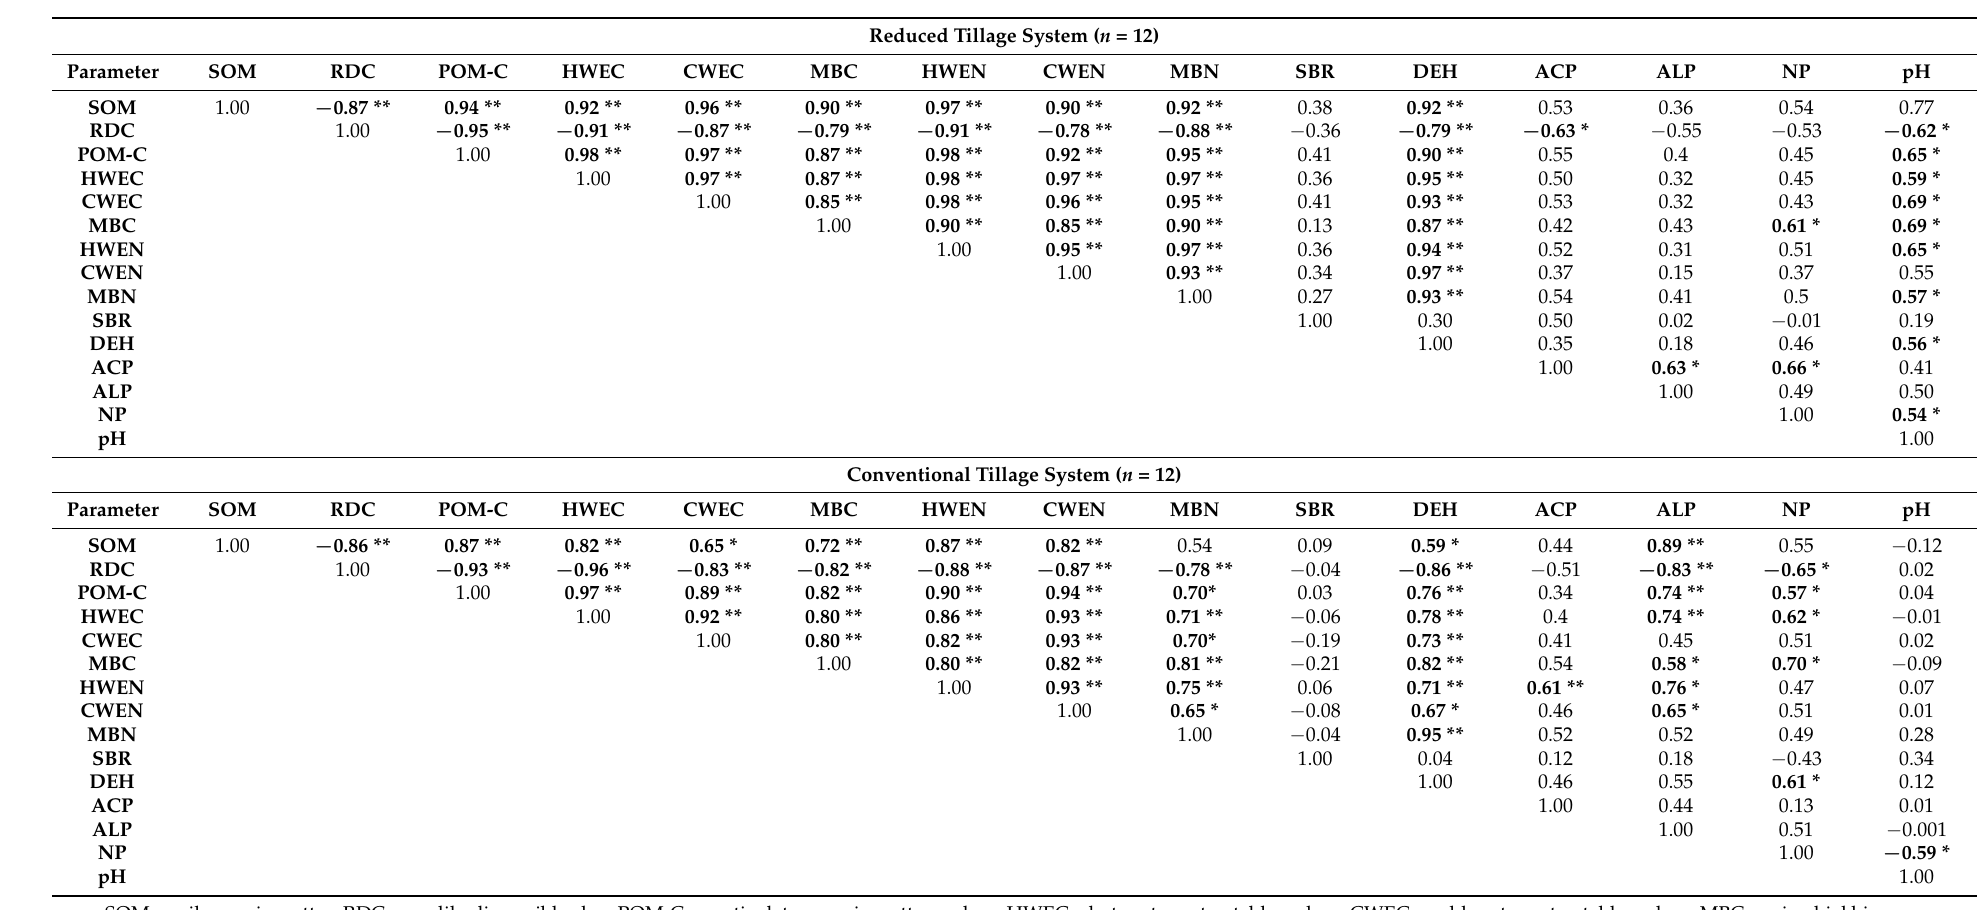
Table 3. Pearson’s correlation coefficients between physical, chemical, and microbiological properties of the analysed